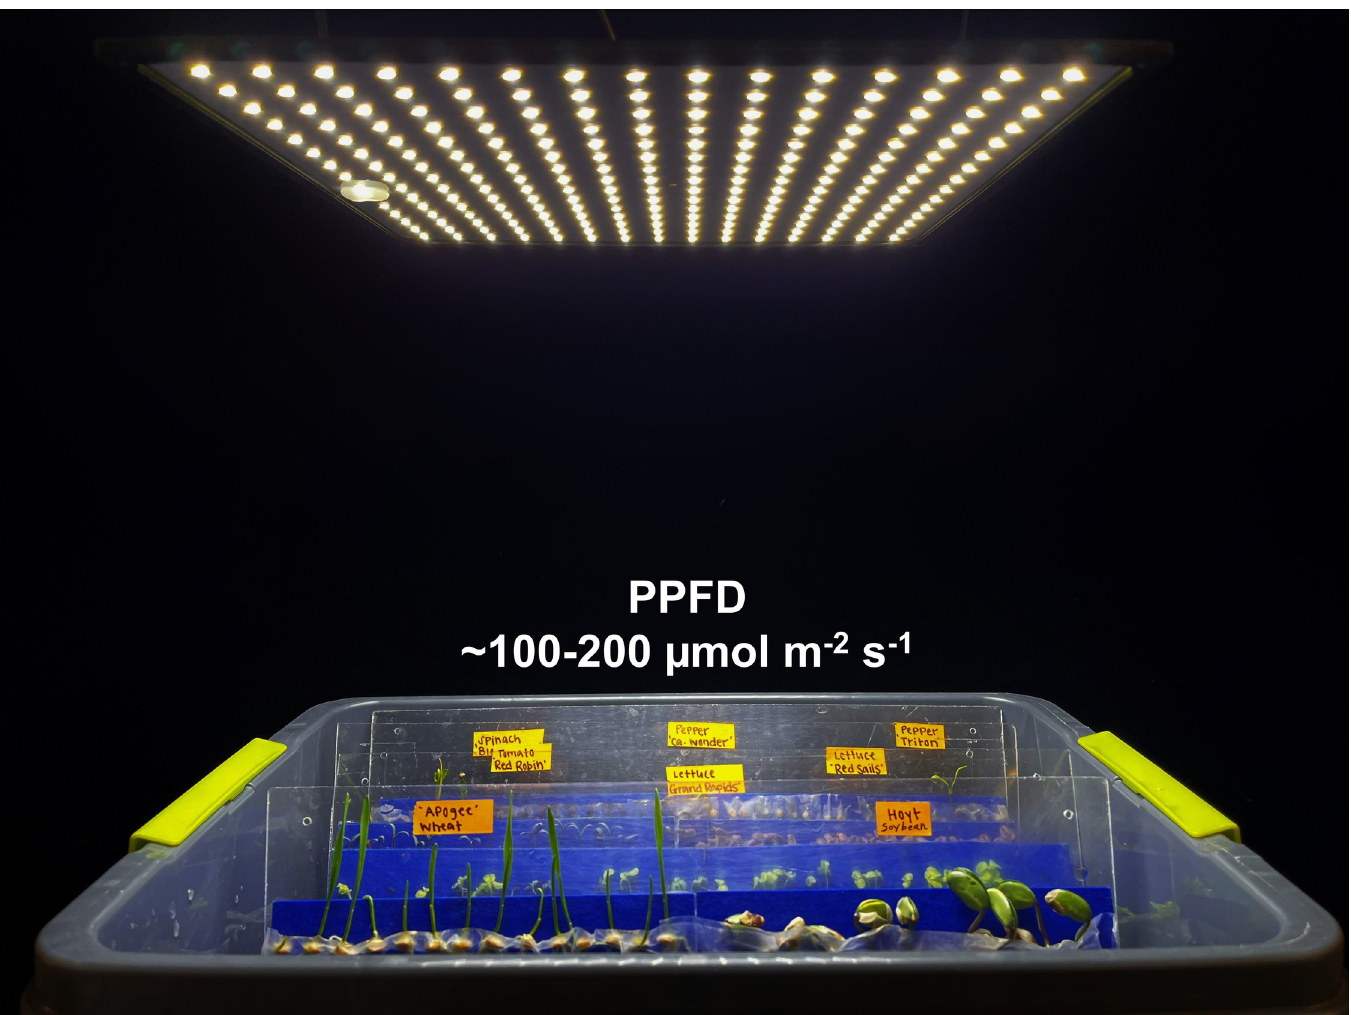
Fig 5. Germination slant boards under LED lights. The photosynthetic photon flux density should be about 100 to 200 μ mol m -2 s -1 to provide adequate light to reduce excessive hypocotyl extension.